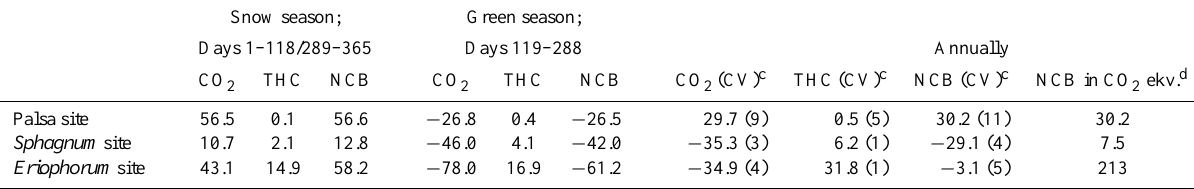
Table 3. The seasonal contribution a for each C component to the annual flux b , in gCm − 2 , separated into snow season, green season and annually. CO 2 , THC, and NCB denote carbon dioxide, total hydrocarbons and net carbon gas balance, respectively. Snow season; Green season;